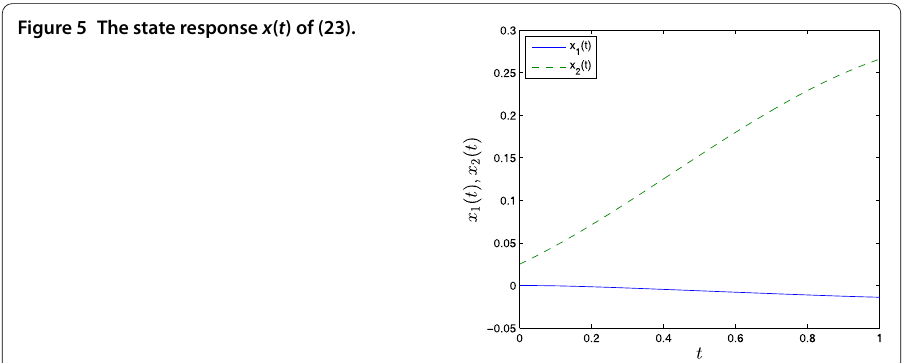
Figure 5 The state response x ( t ) of